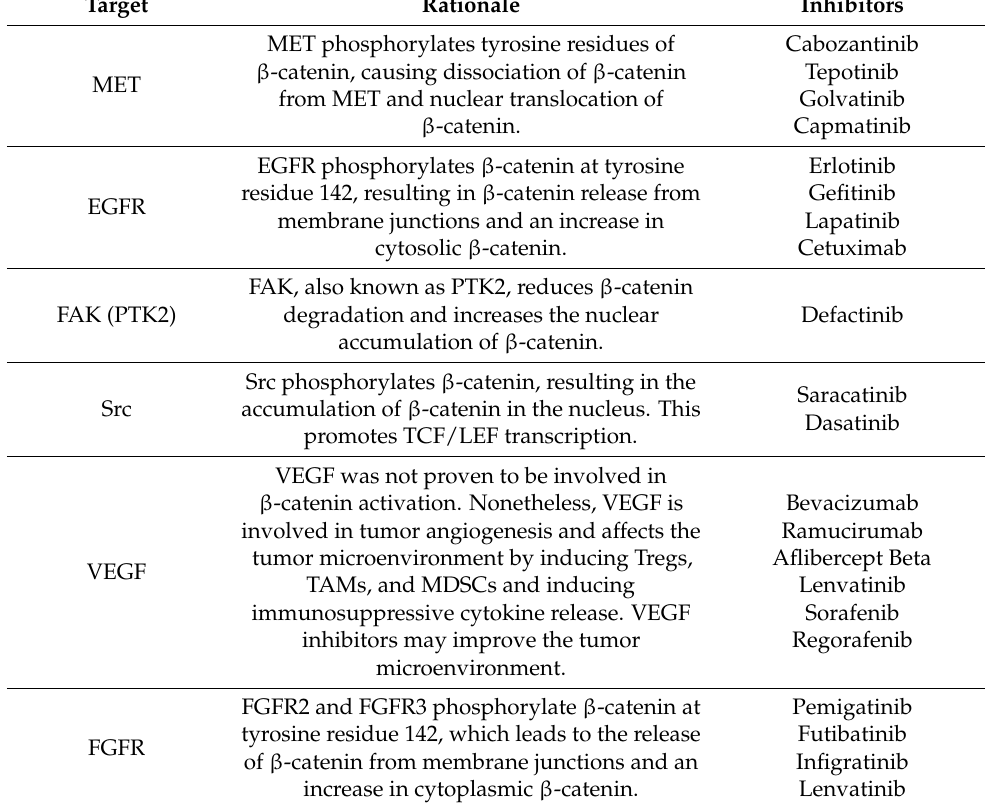
Table 2. Therapeutic targets for improving the tumor immune